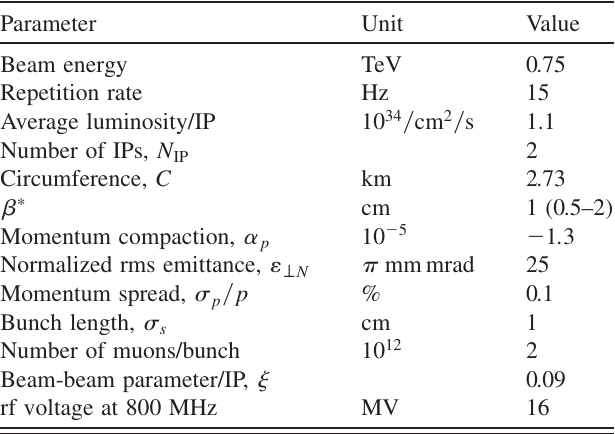
TABLE I. Baseline muon collider parameters